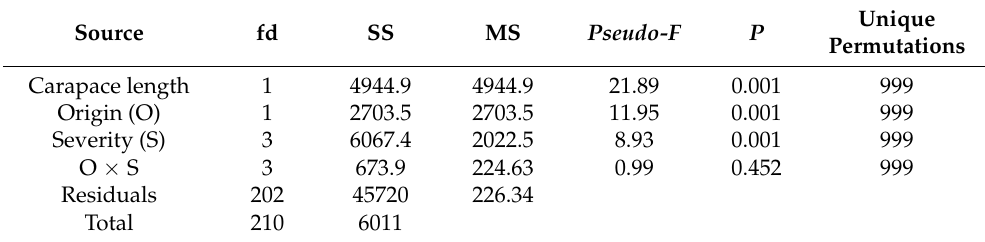
Figure 2. Box plots of immunological indicators measured in Panulirus argus either naturally or experimentally infected with PaV1. Severity of the infection (0: uninfected; 1: lightly; 2: moderately; and 3: severely infected), on the basis of PCR and histological criteria. PO: total phenoloxidase activity. Interpretation of univariate statistical features depicted in these figures must be carried out with caution, since they assume that all the response variables are uncorrelated and independent of each other. Table 2. MANOVA with permutations applied to the values of the immunological response measure- ments in Panulirus argus, either naturally or experimentally infected with PaV1. Experimental design was a two-way model with the origin of the infection (O) as a fixed factor with two levels (naturally and experimentally infected); severity of the infection (S) as a fixed factor with four levels (0, 1, 2 and 3); and carapace length (CL) as a